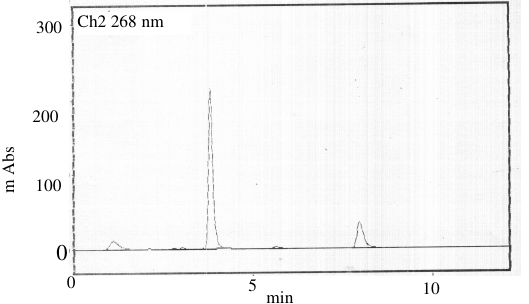
Figure 3. Typical chromatogram of itopride hydrochloride and rabeprazole sodium in marketed